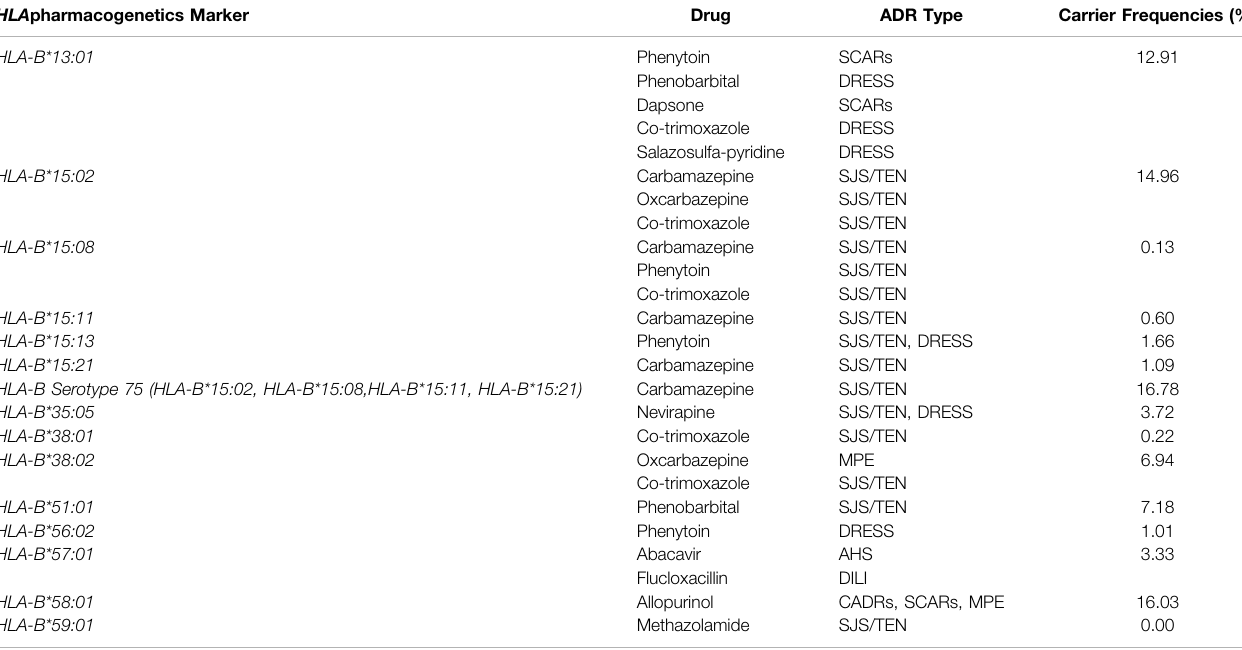
TABLE 1 | The HLA-B alleles associated with cutaneous adverse drug reactions (CADRs) and carrier frequency of Thai population (N =